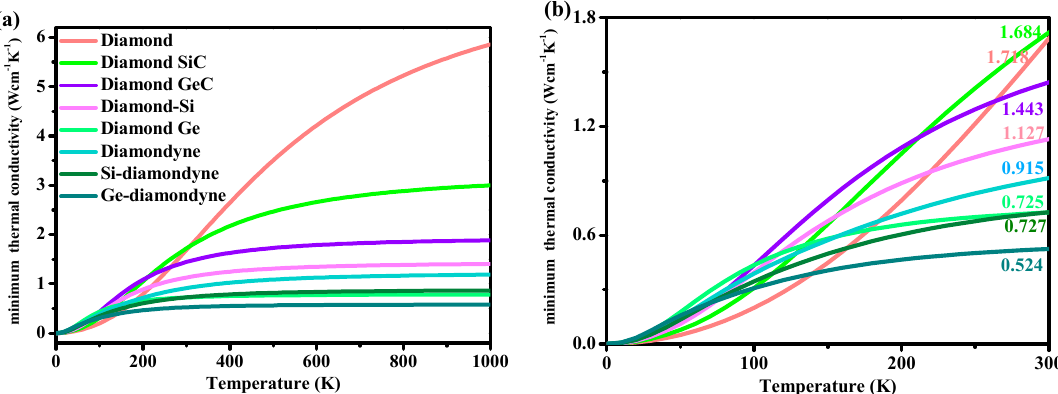
Figure 6. The relationships between temperature and the minimum thermal conductivity κ min of diamond, zinc blende-SiC, diamond-GeC, diamond-Si, diamond-Ge, diamondyne, Si-diamondyne and Ge-diamondyne, ( a ) 0–1000 K; ( b ) 0–300 K.